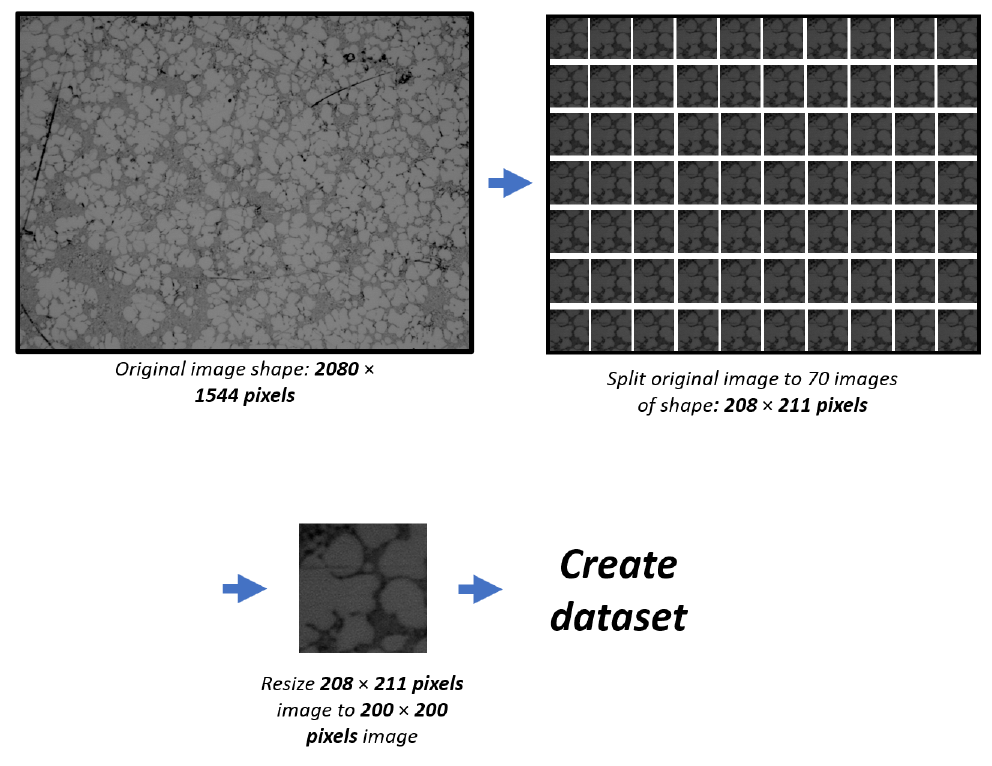
Figure 5. Schematic representation of dataset generation: the original image was first split into 70 images with a pixel resolution of 208 × 211, which were then resized to 200 × 200